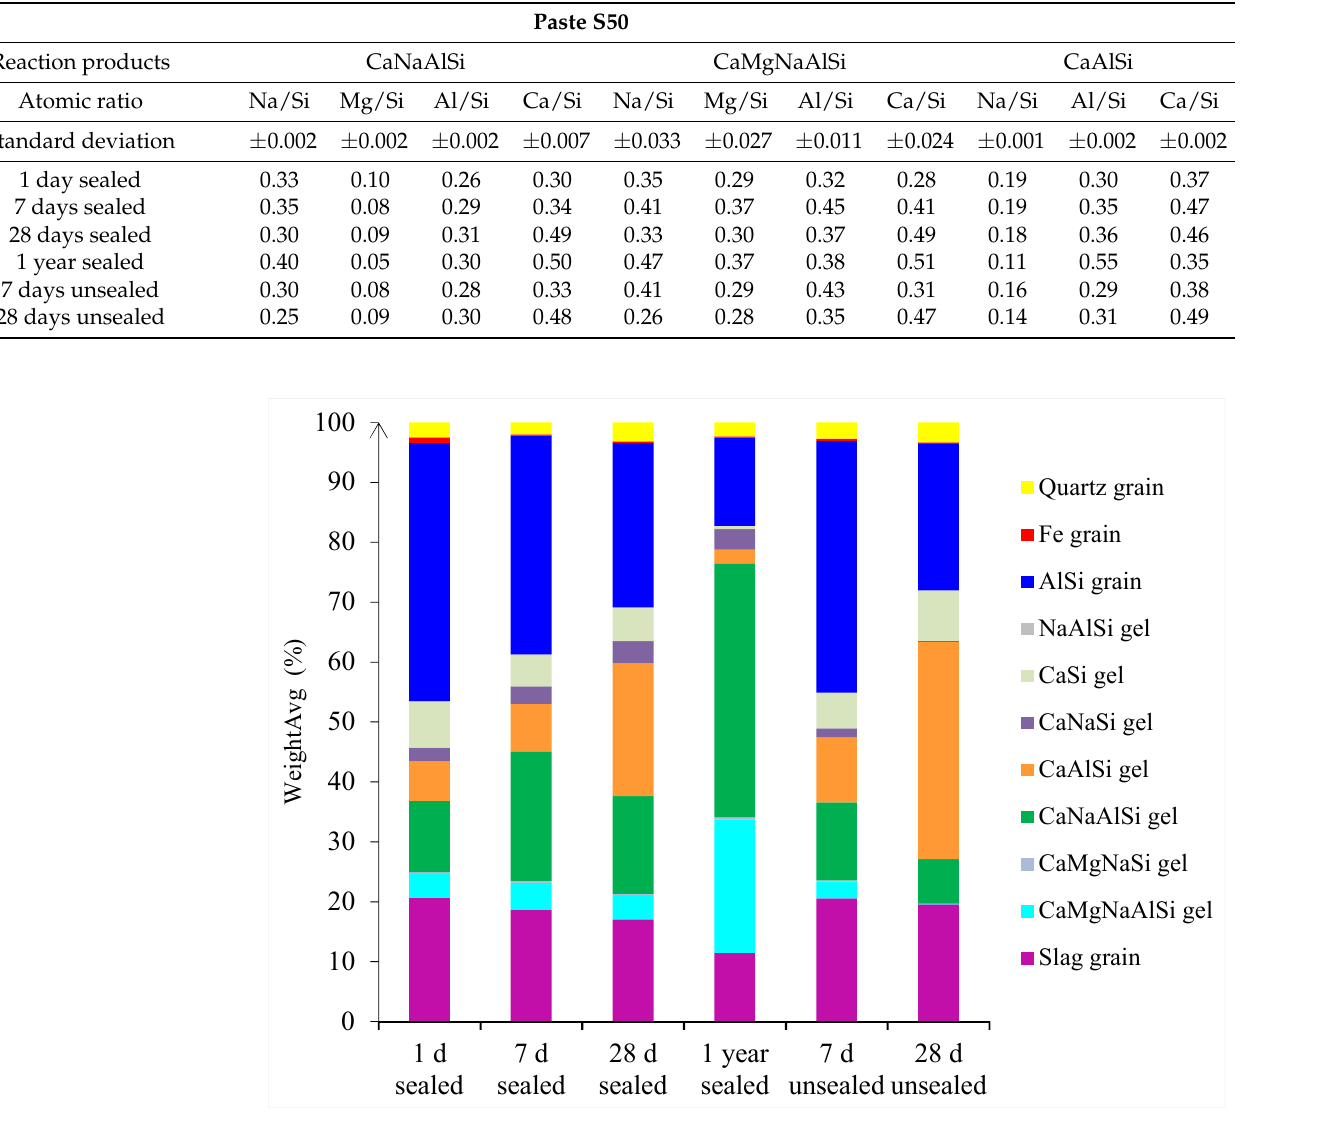
with the one reported by Brough et al. [37].